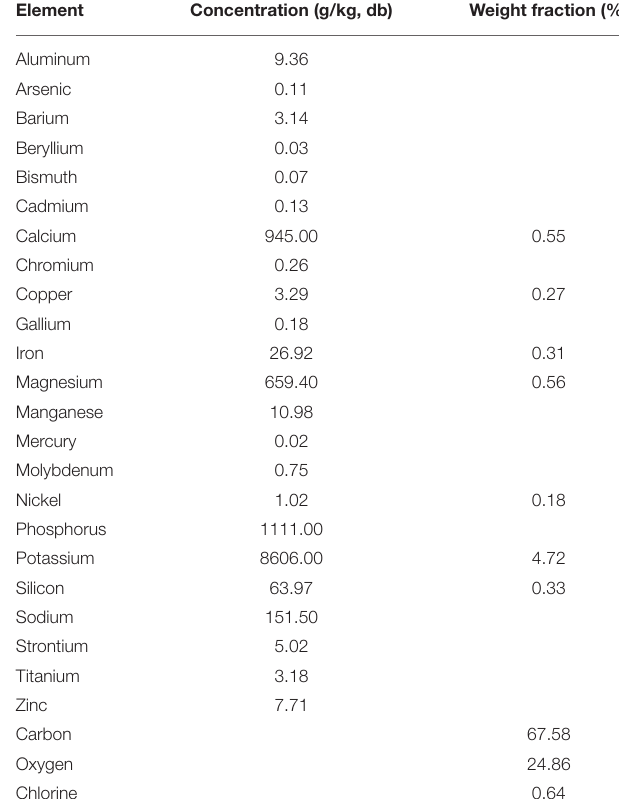
TABLE 1 | Raw tomato peels properties.